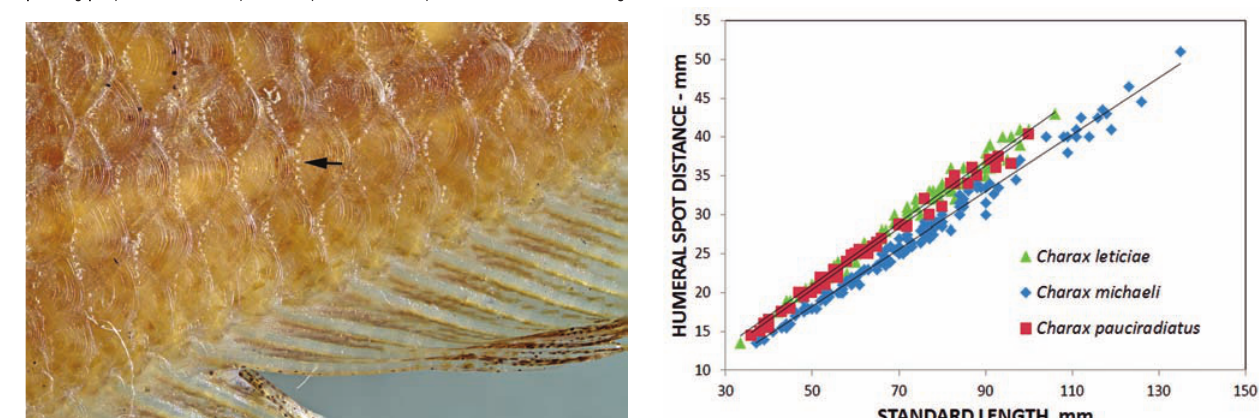
Fig. 1. Superficial neuromasts (black arrows) on lateral body scales of Charax delimai , male (a), MZUSP 81325, paratype, 102 mm SL, Brazil, Amazonas, igarapé Umari, tributary of rio Tiquié in community of São Pedro and female, (b), MZUSP 84988, paratype, 102 mm SL, Brazil, Amazonas, near old community of São Pedro.